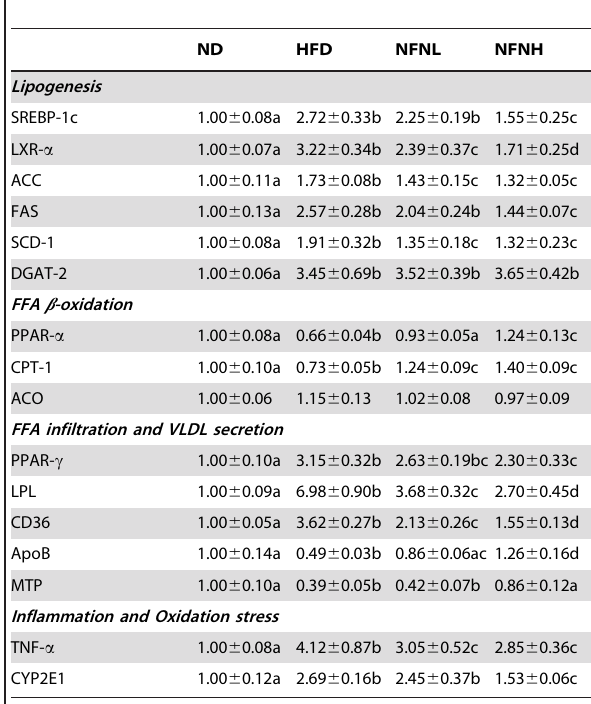
Specific mRNA values were normalized to the expression of 18S rRNA as described in Materials and Methods. Values are expressed as the means 6 SD (n=4 , 6) relative to the values obtained in hamsters fed the normal diet at 8 weeks, which were arbitrarily assigned a value of 1.00. ND: normal diet group, HFD: high-fat diet group, HFNL: low dosage nuciferine group (HFD + 10 mg/ kg ? BW/day), HFNH: high dosage nuciferine group (HFD + 15 mg/kg ? BW/day). a, b, c, d: Means in the same row with different online letters differ significantly, p , 0.05.